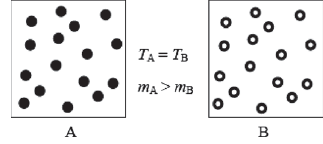
FIG. 11. Second page of the kinetic molecular theory of gases concept